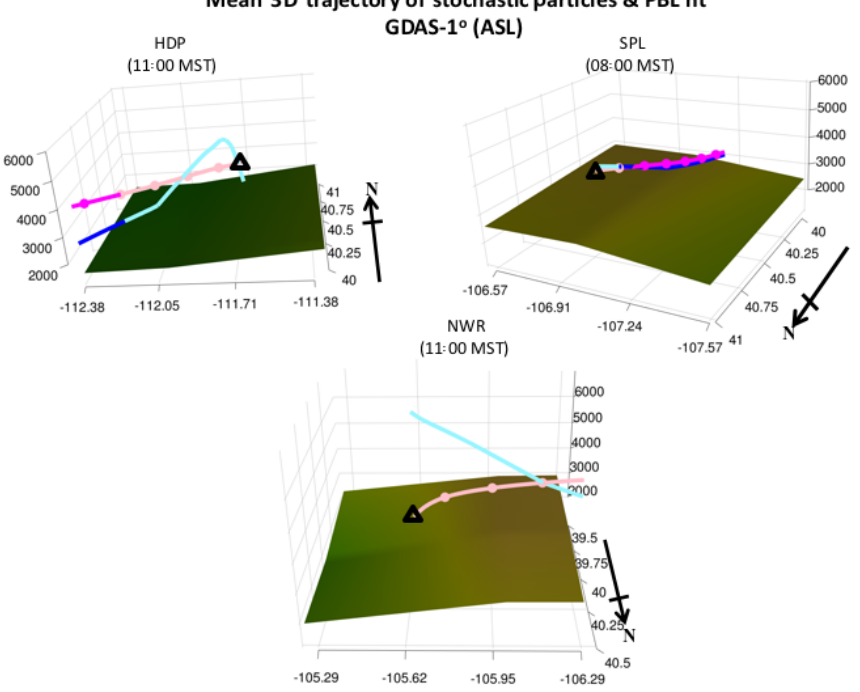
Figure 13. Similar to three-dimensional terrain and trajectory plots as shown in Figs. 7, 9, and 11, but for just the GDAS 1 ◦ . ASL simulations and for the morning hours of 08:00 and